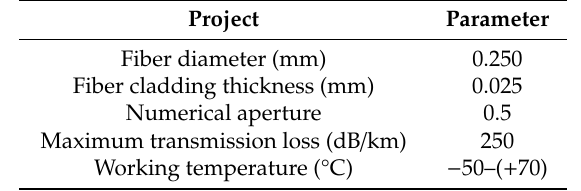
Table 1. Characteristics of the polymer optical fibers (POFs) used in this study.